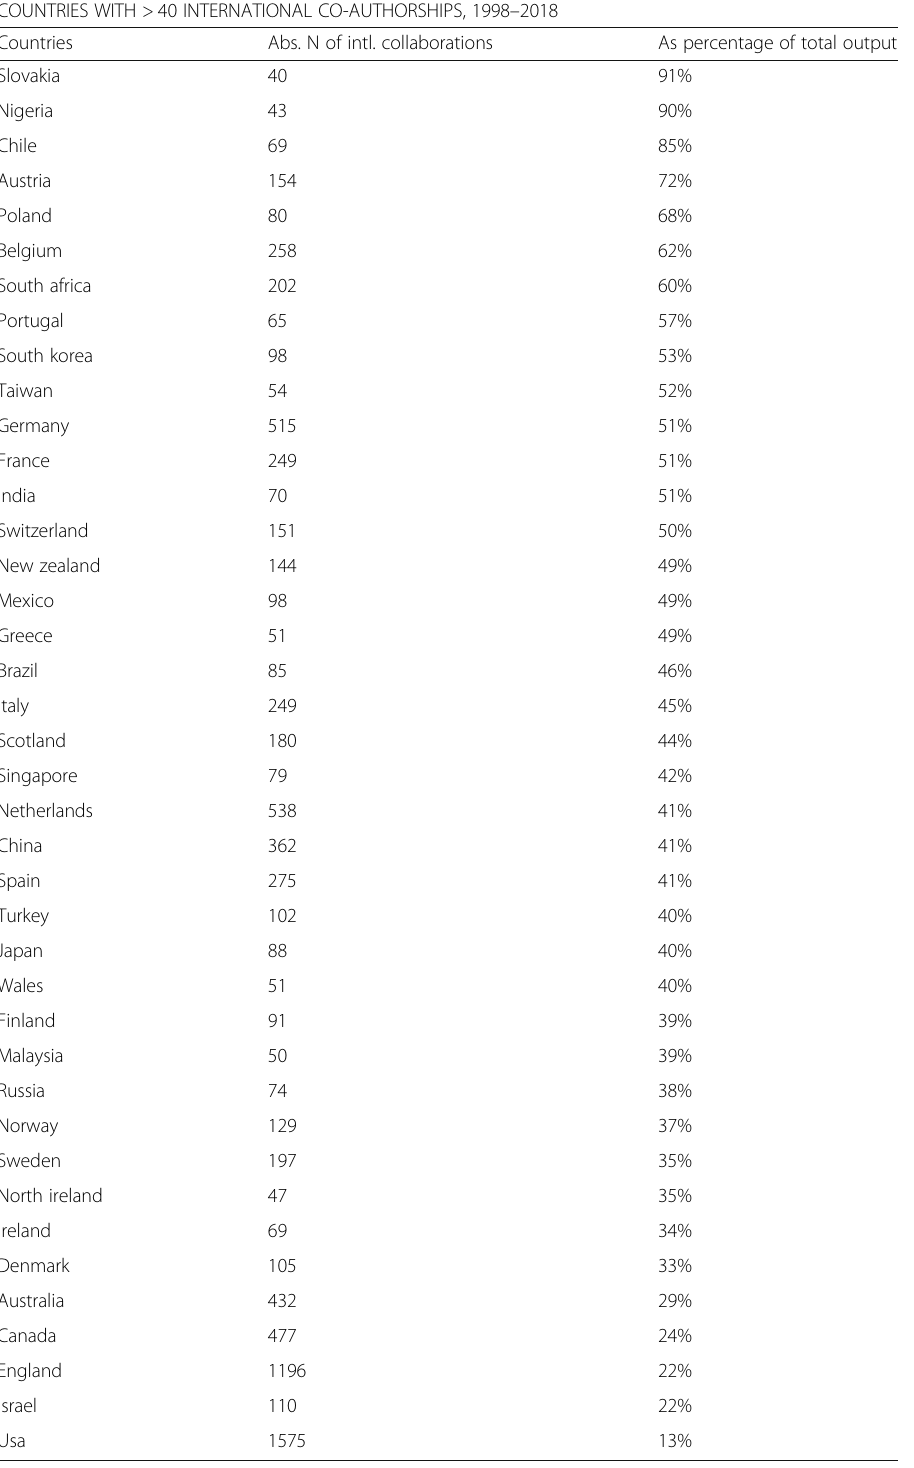
Table 2 Countries with >40 international co-authorships 1998-2018 COUNTRIES WITH > 40 INTERNATIONAL CO-AUTHORSHIPS, 1998 – 2018 Countries Abs. N of intl. collaborations As percentage of total